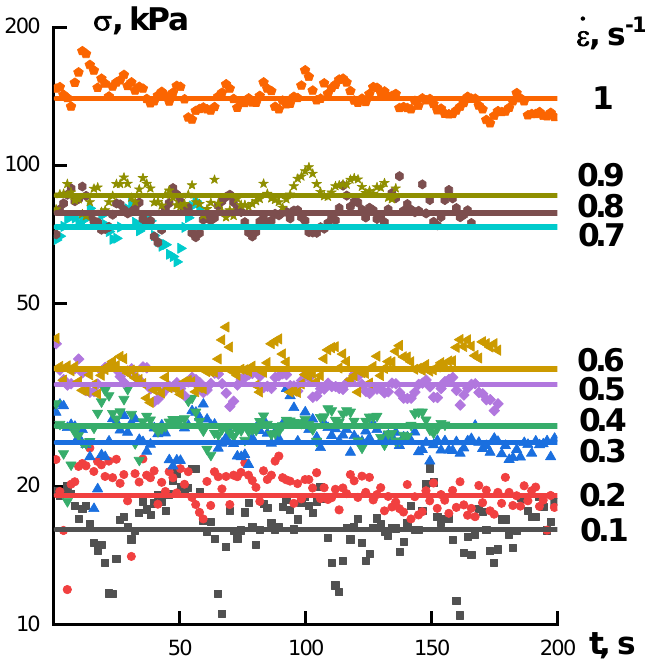
Figure 13. Stresses during stationary stage of the continuous spinning of PAN from DMSO solutions.